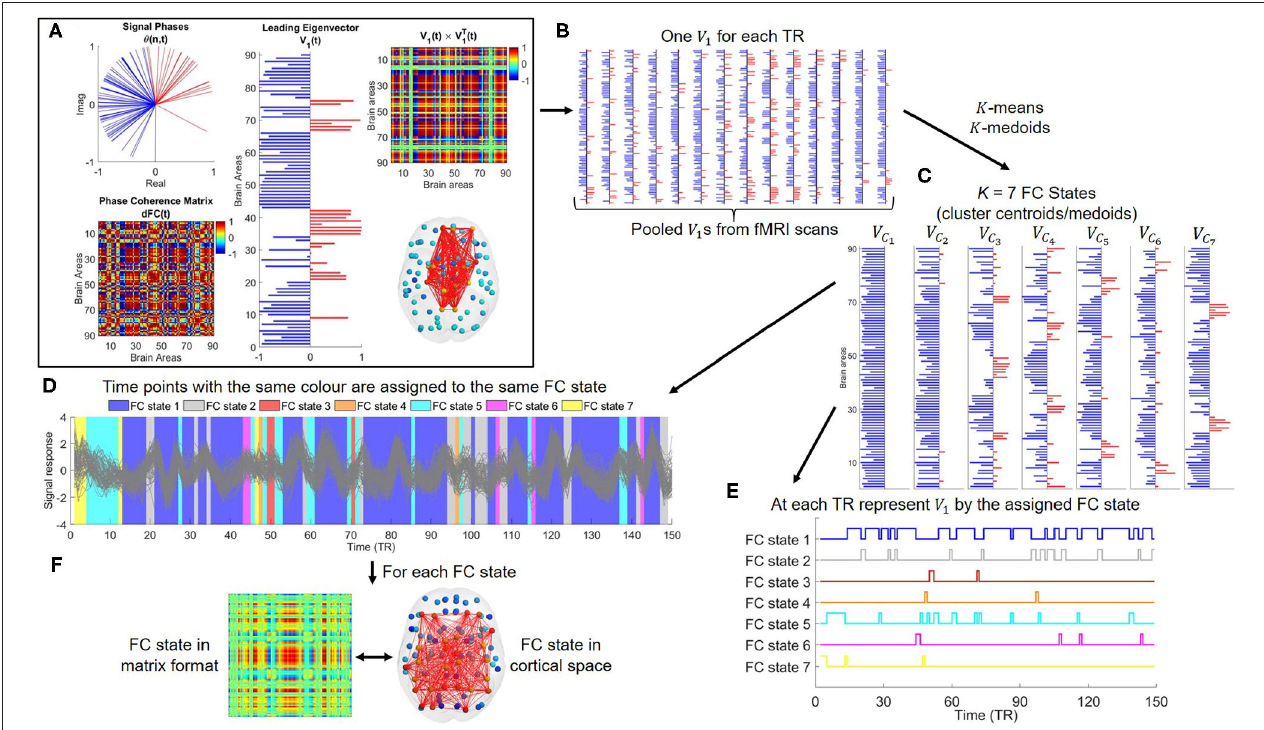
FIGURE 1 | Graphical illustration of the estimation and characterization of the temporal trajectories of recurrent FC states obtained by using Leading Eigenvector Dynamics Analysis (LEiDA). (A) Phases of all N = 90 brain areas in the complex plane at time t (top left); Phase coherence matrix at time t , dFC ( t ) (bottom left); Vector representation of the leading eigenvector, V 1 ( t ), of dFC ( t ) (middle); Matrix representation of V 1 ( t ) (top right); Network representation of V 1 ( t ), with links between the areas with positive elements in V 1 ( t ) plotted in red (bottom right). (B) The leading eigenvectors are computed for each time point and from all fMRI scans. (C) The pooled leading eigenvectors are partitioned into K clusters using a clustering algorithm. The cluster centroids/medoids are assumed to represent recurrent patterns of phase coherence (FC states). (D,E) The leading eigenvector at each TR is represented by the centroid/medoid of the cluster to which it was assigned by the clustering procedure. This originates time courses of FC states for each fMRI session. The time courses are then characterized using tools from dynamical systems theory. (F) Each FC state can be represented as a N × N matrix (outer product) and as a network in cortical space (elements with positive sign linked by red